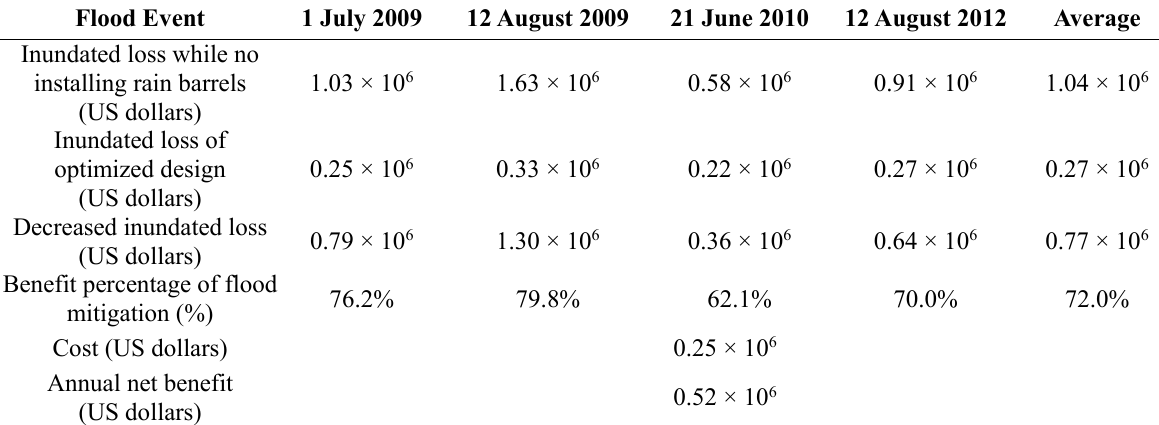
Figure 13. Comparison on full pipe percentage of water flow and flooding volume between optimal rainwater harvesting systems (RWHS) design, best design of simulation method and original no design: ( a ) CP1; ( b ) CP2; and ( c ) CP3. Table 6. Net benefit of optimized design of rainwater harvesting